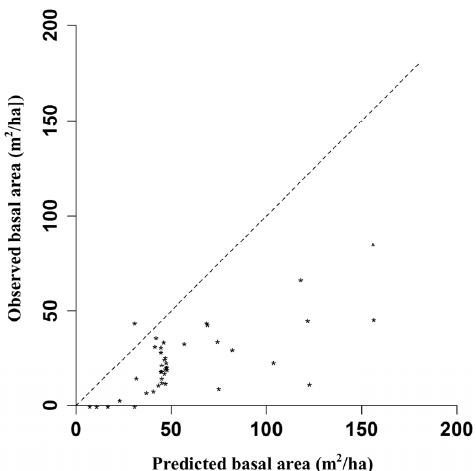
Figure C1. Comparison of empirical basal area and simulated basal area using Plonski’s yield table.